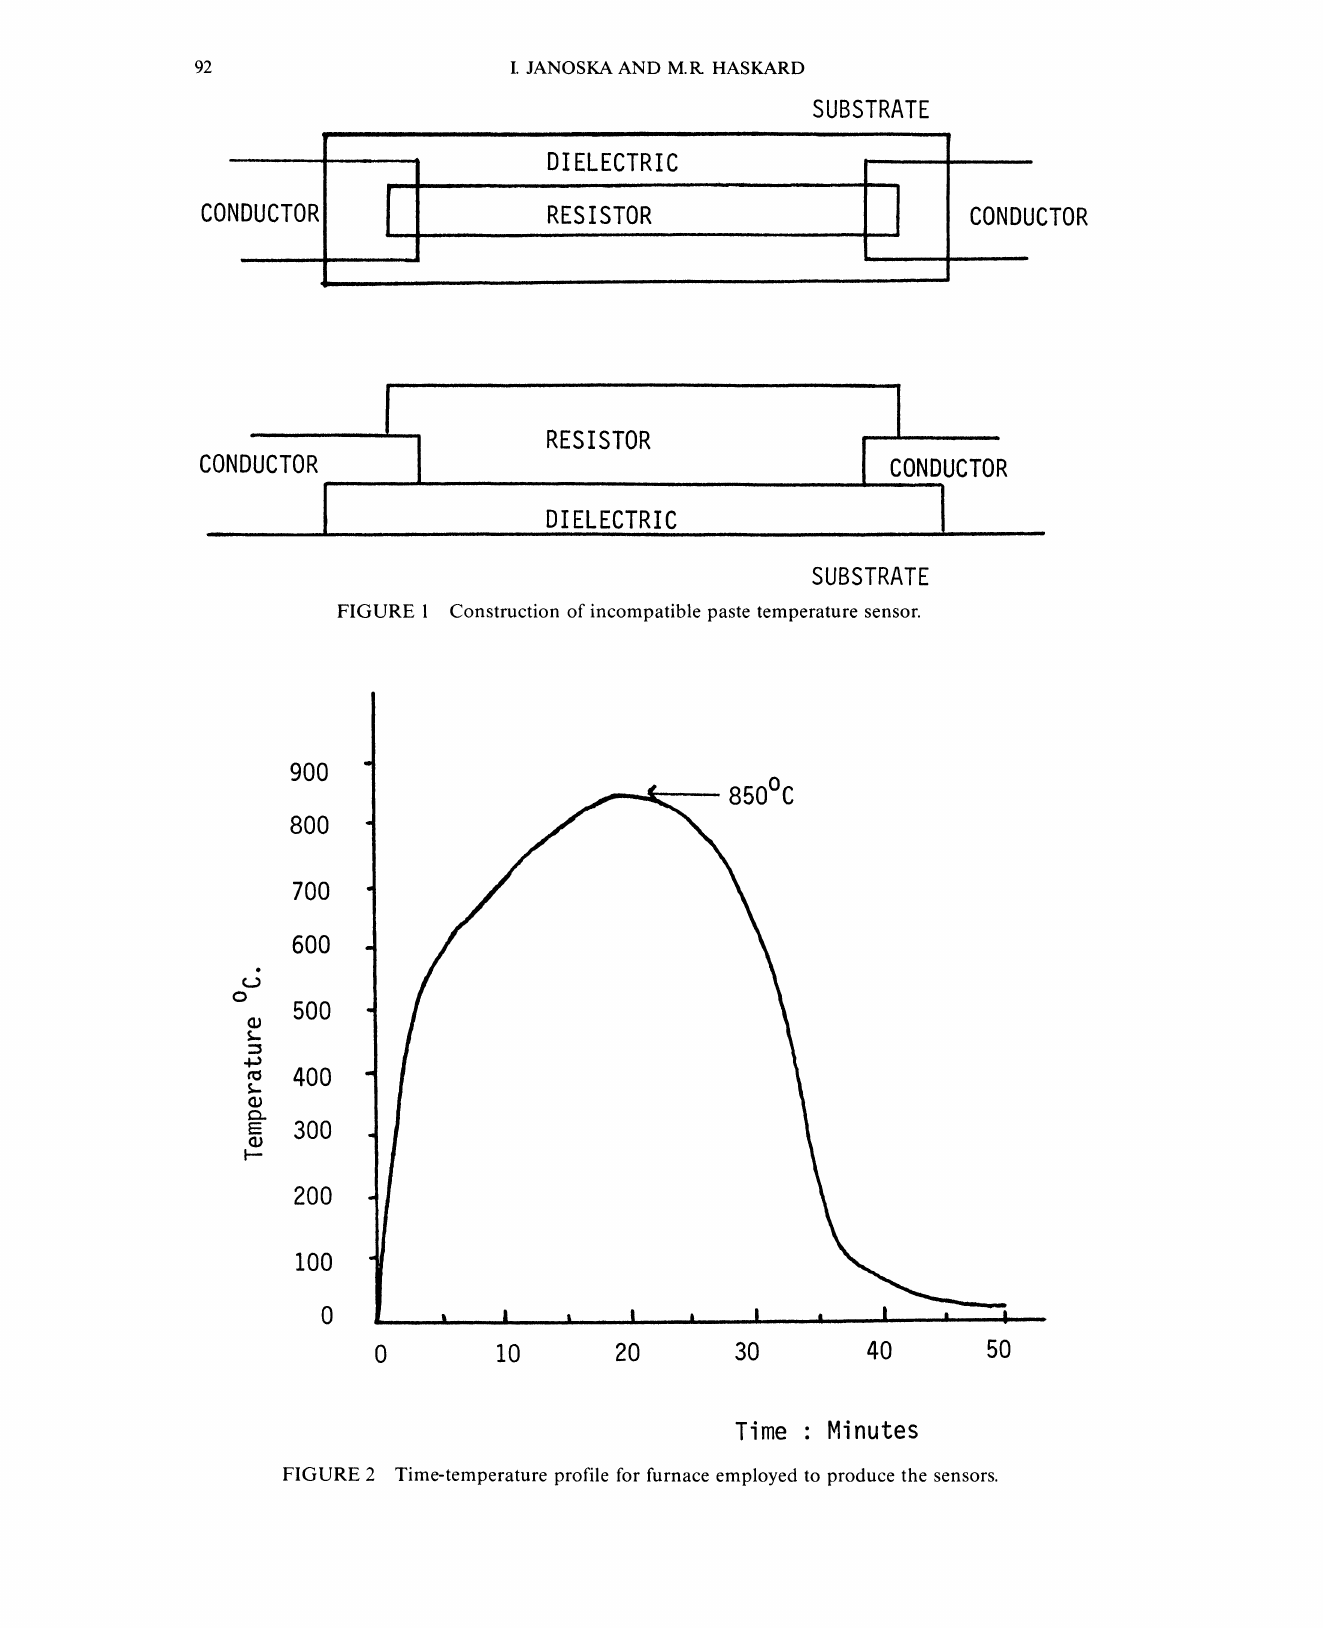
FIGURE 2 Time-temperature profile for furnace employed to produce the